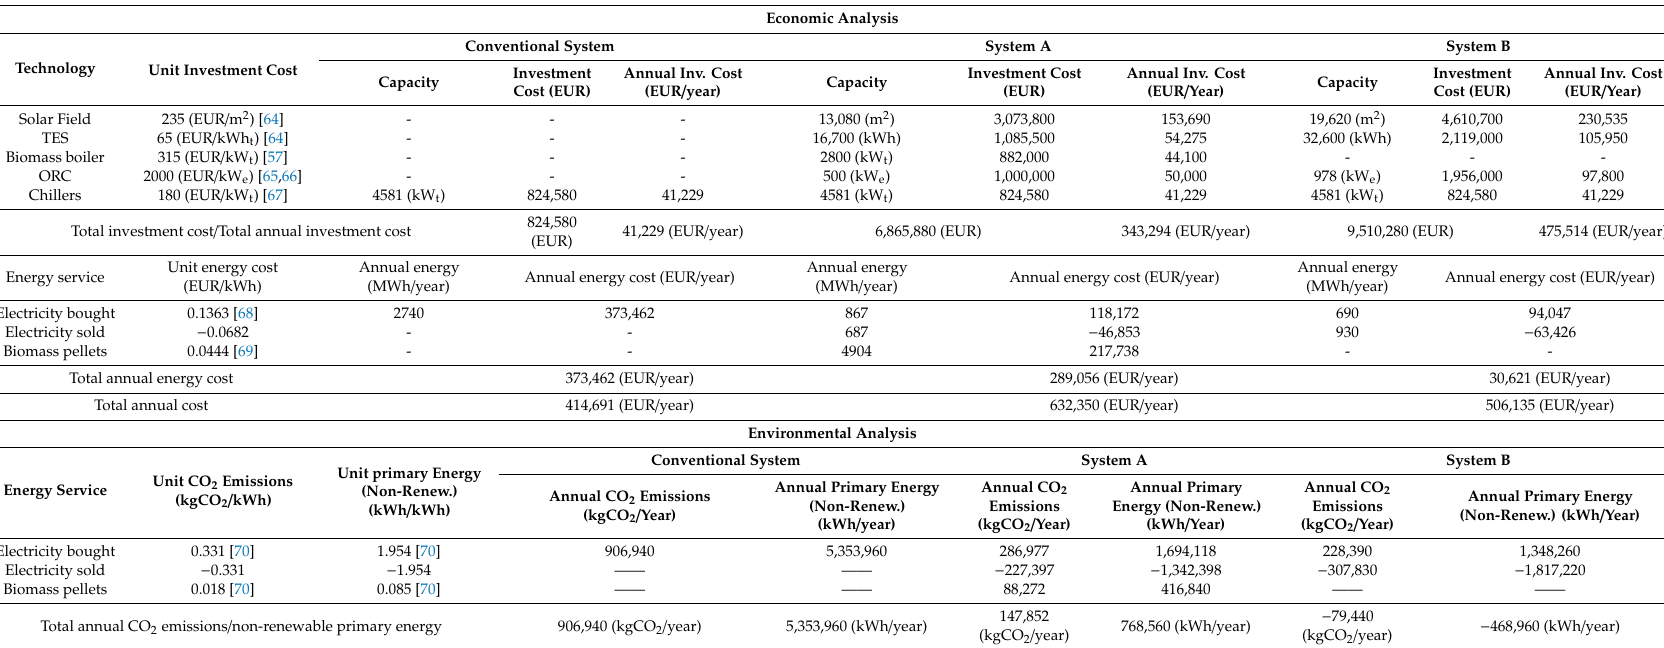
Table 5. Economic and environmental analyses of the conventional system and systems A and B.